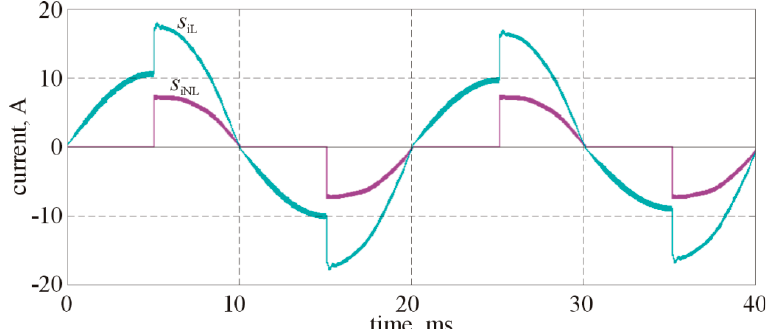
Figure 9. Waveforms for the PSP input current and nonlinear load current when the PSP compen- sation function was disabled.